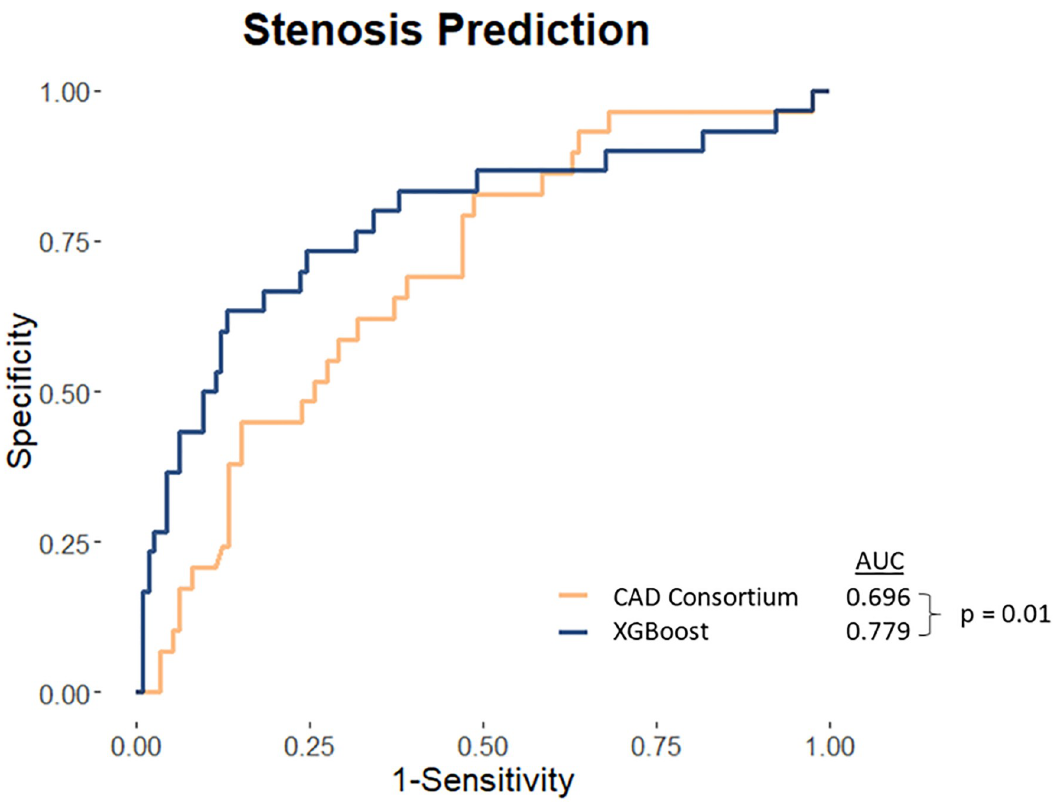
Fig 2. Receiver Operating Characteristics (ROC) analysis for the prediction of obstructive coronary artery disease using non- imaging variables. Abbreviations: AUC = Area under curve, CAD = Coronary artery disease.